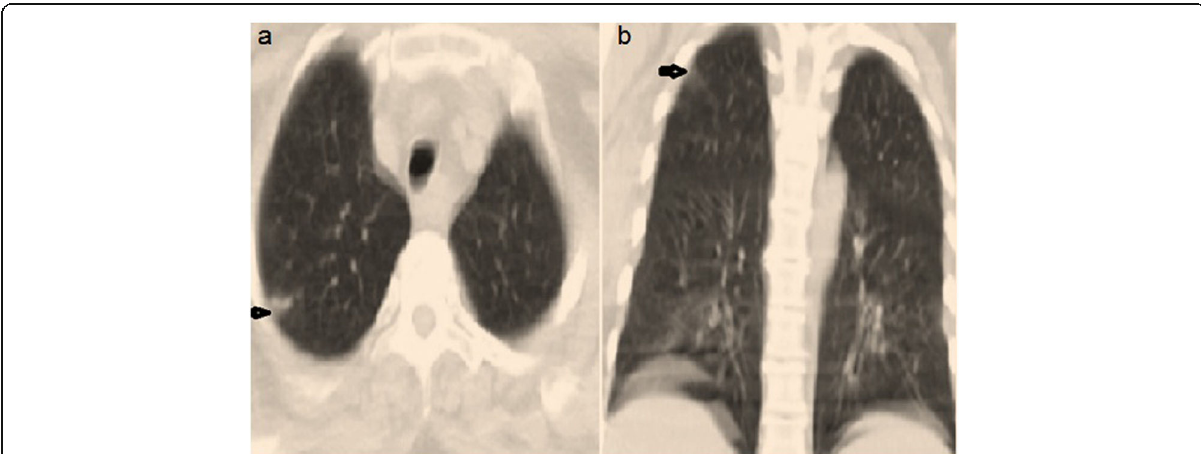
Fig. 1 “ A 47-year-old male patient with a history of rectum cancer. ” MCCT exam revealed a small well-defined solid nodule about 6 x3mm at the posterior aspect of the Rt. Upper lung lobe ( a ) axial ( b ) coronal image that is categorized as lung-RADS score III “ benign solid nodular lesion ” that